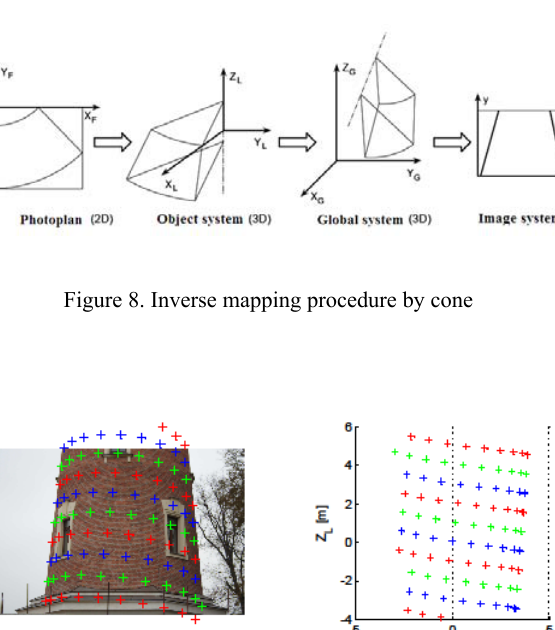
Figure 7. Inverse mapping – principle